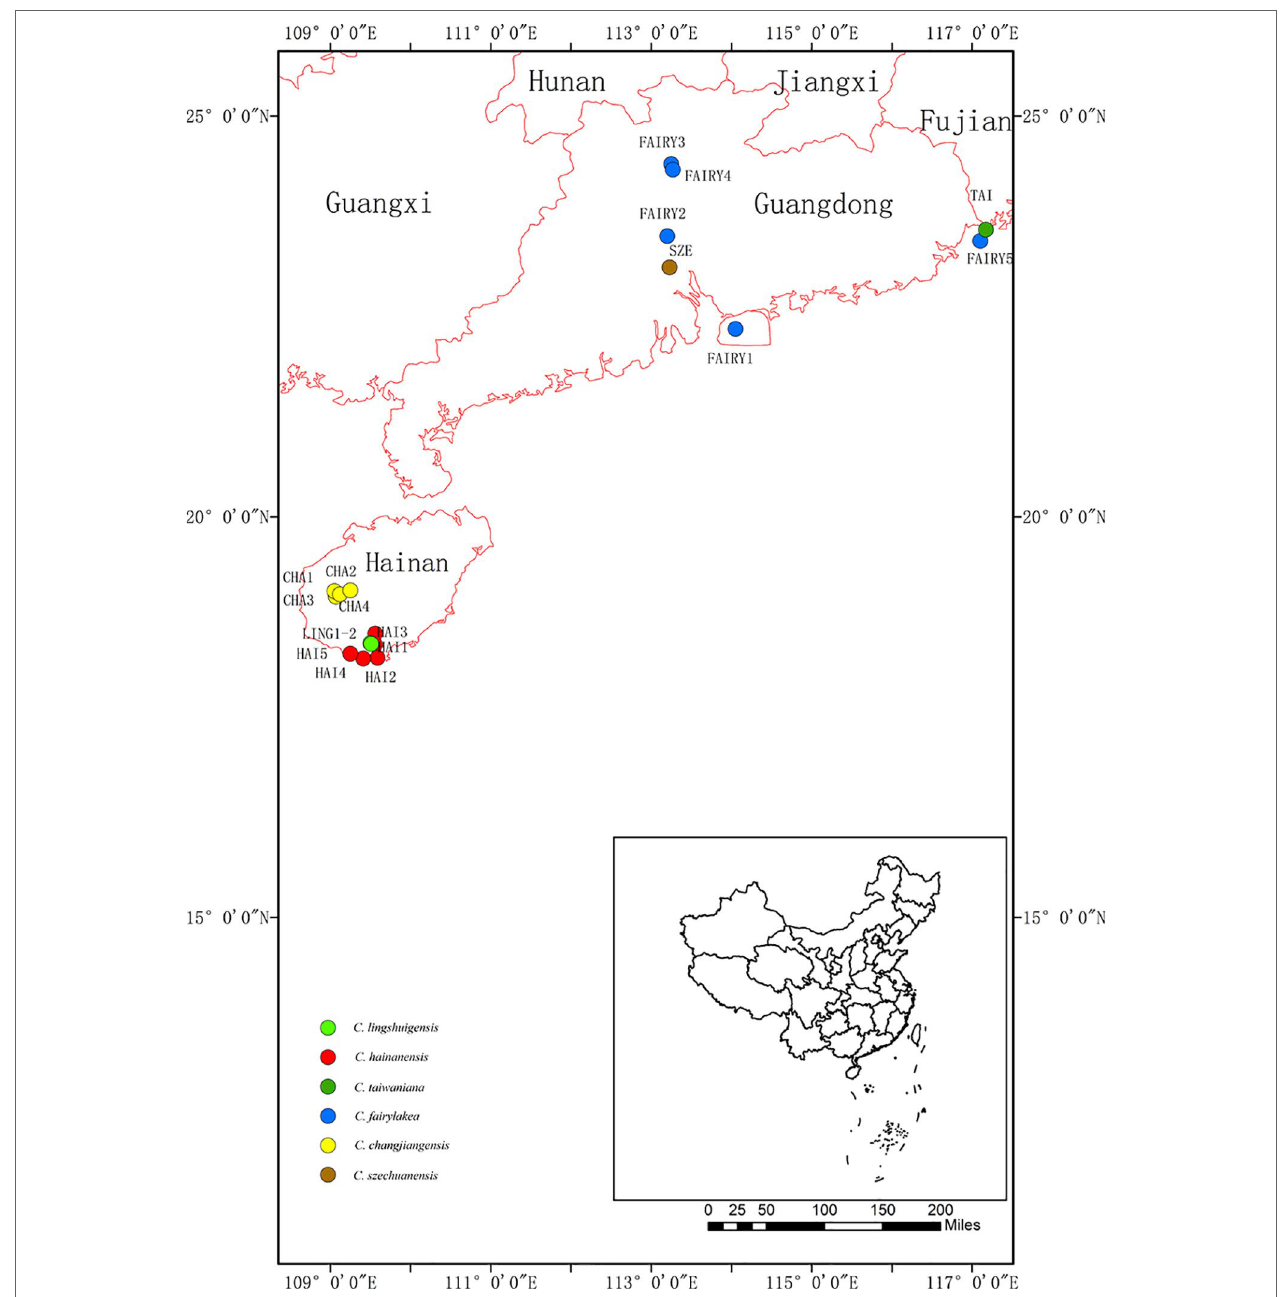
FIgUrE 1 | Geographical distribution of 18 populations in the Cycas taiwaniana complex. Population codes are explained in Table 1 .